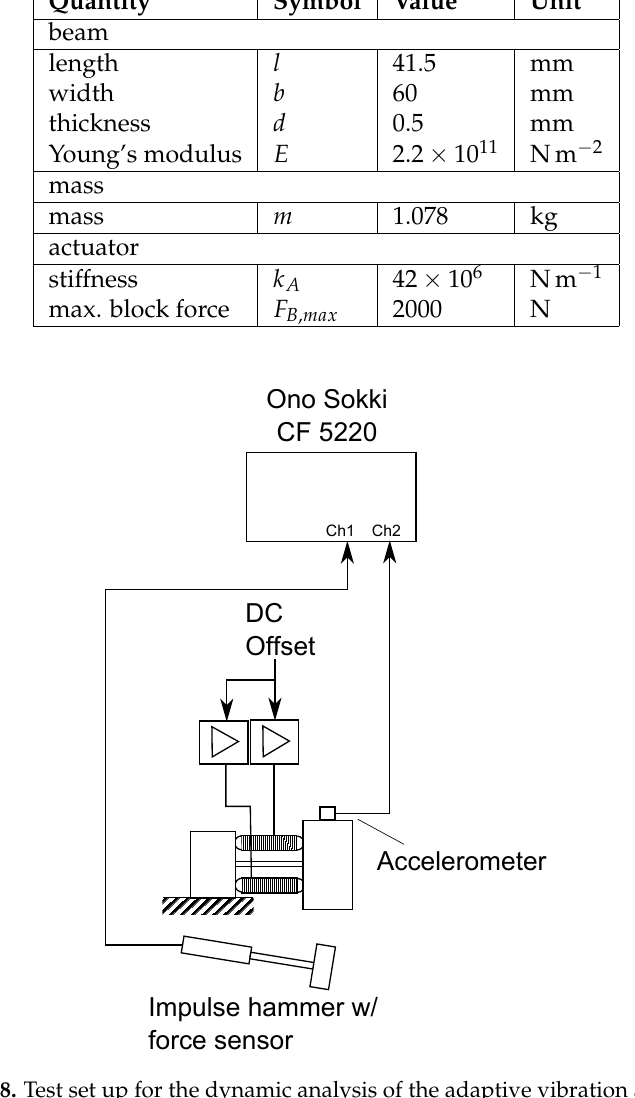
Figure 8. Test set up for the dynamic analysis of the adaptive vibration